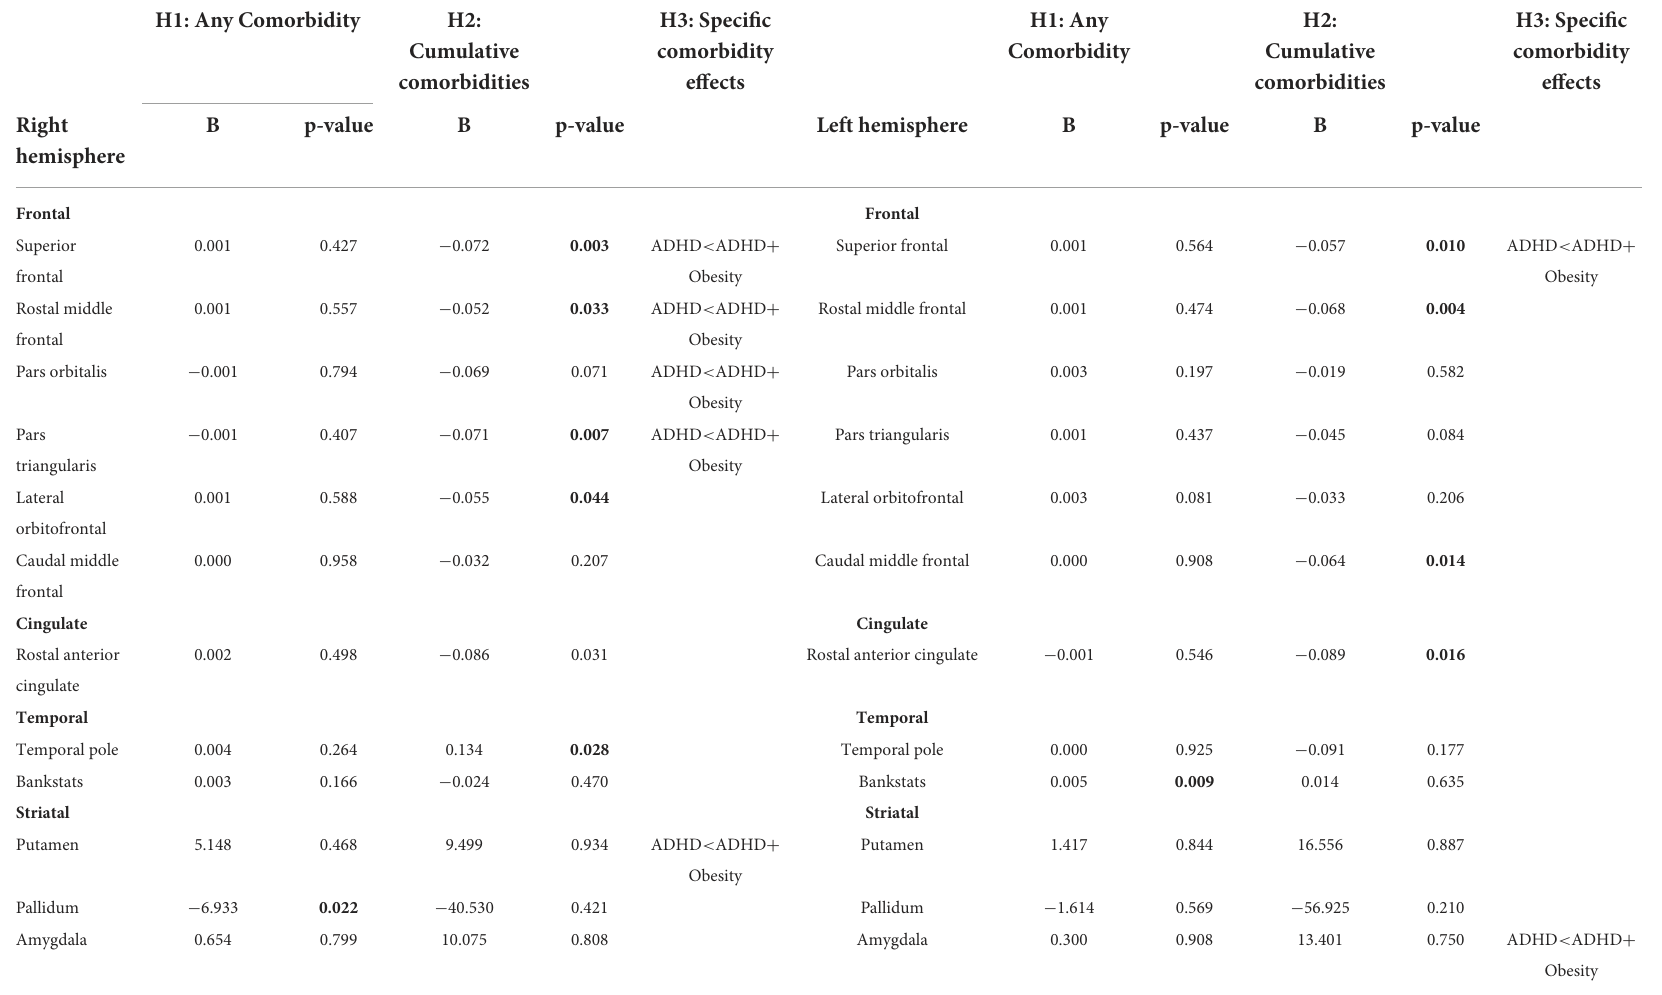
TABLE 2 FreeSurfer results on cortical thickness and subcortical volumes (only uncorrected significant values are